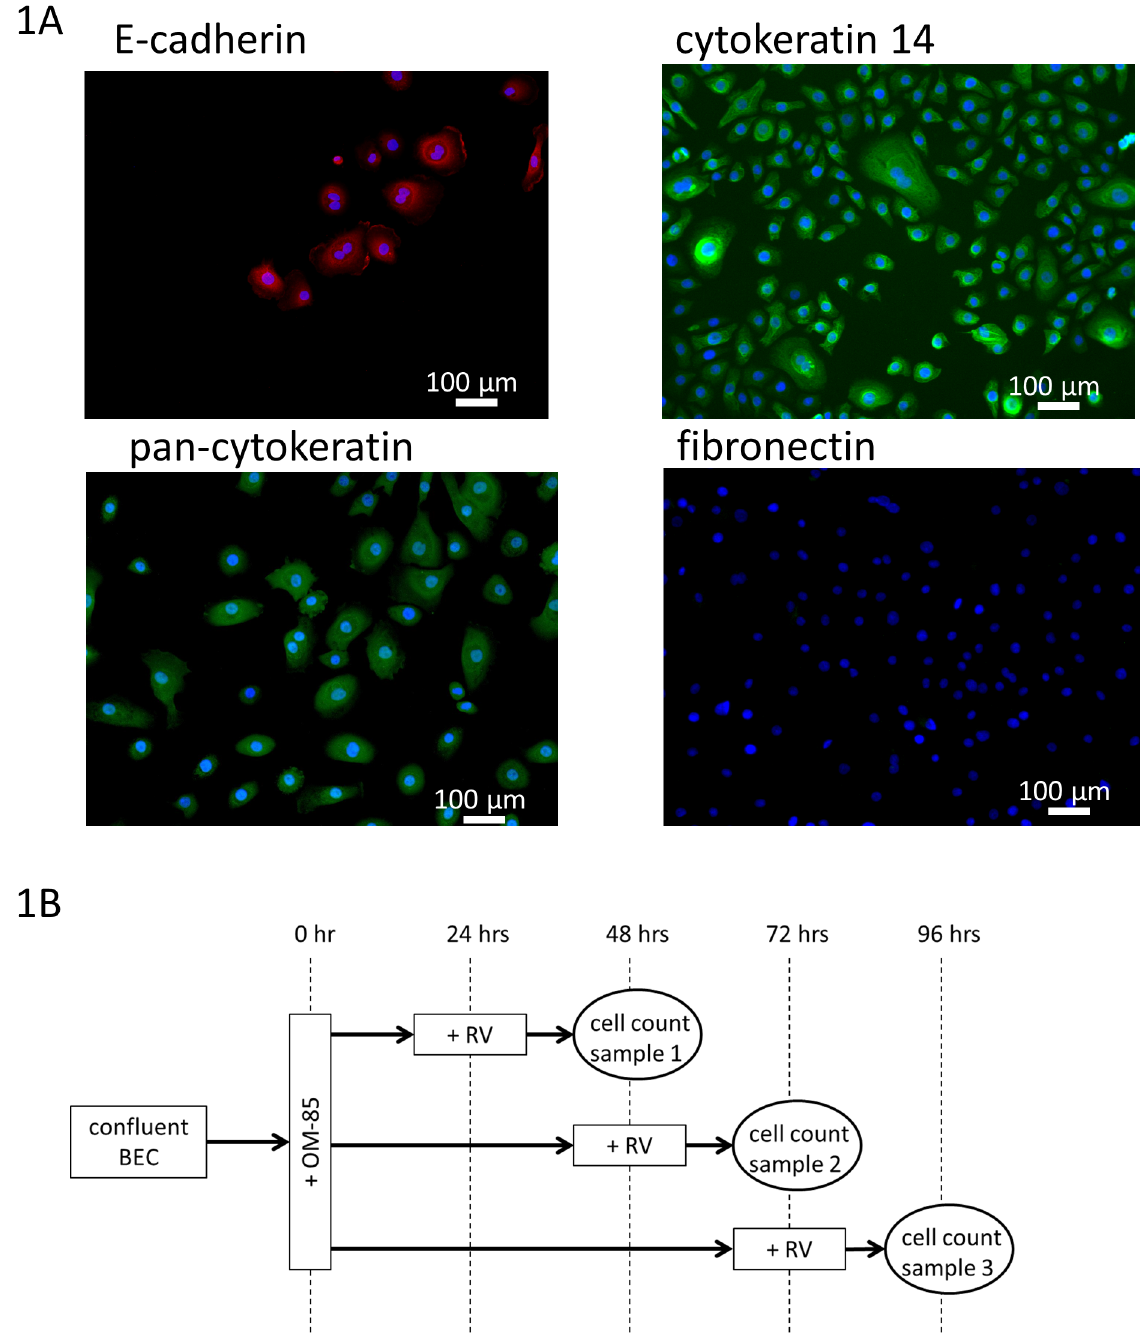
Fig 1. (A) BEC characterisation by IF-staining for: E-cadherin, cytokeratin-14, pan-cytokeratin and negative stainingfor fibronectin. Images were obtainedby EVOS microscope (ThermoFisher Scientific, Switzerland). (B) Treatment schemata for BEC treatment with OM-85 and RV